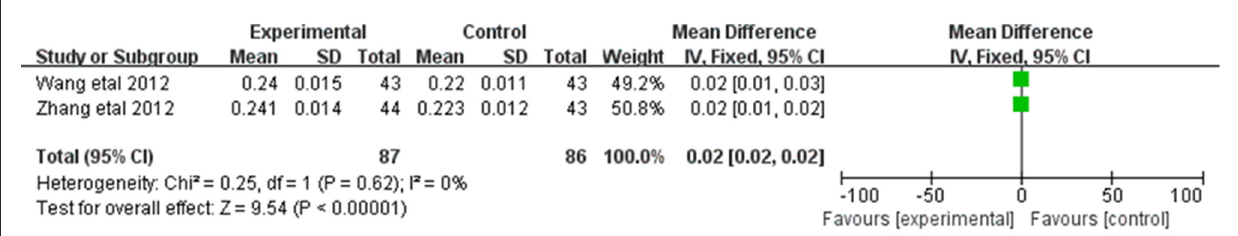
FIGURE8 Forest plot of analysis of the ArE of treating CHF.